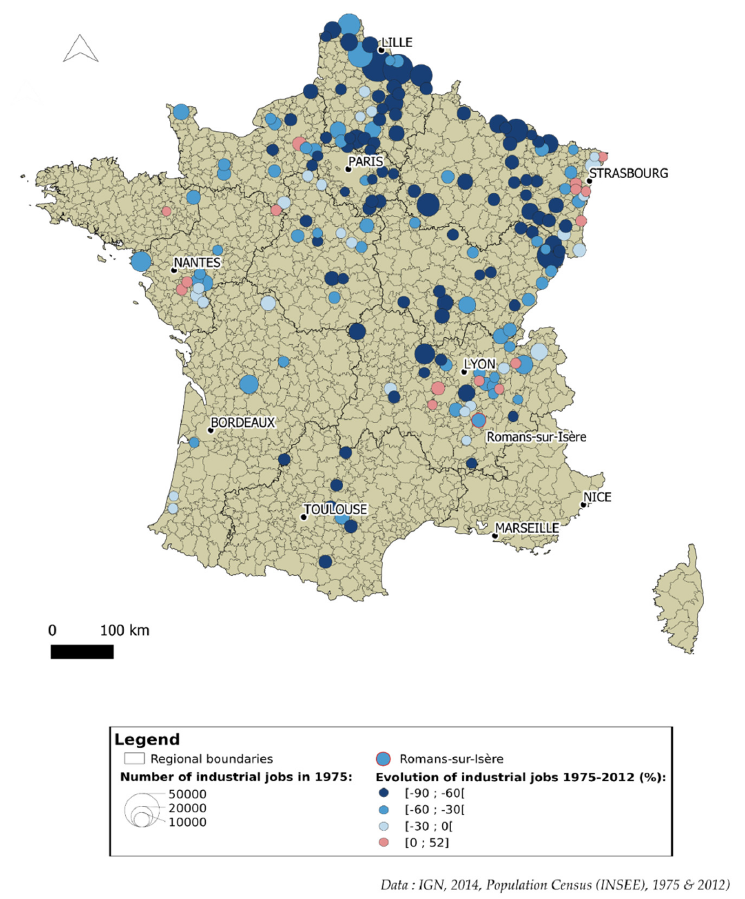
Figure 1. Location of French medium-sized industrial towns (source: Authors).